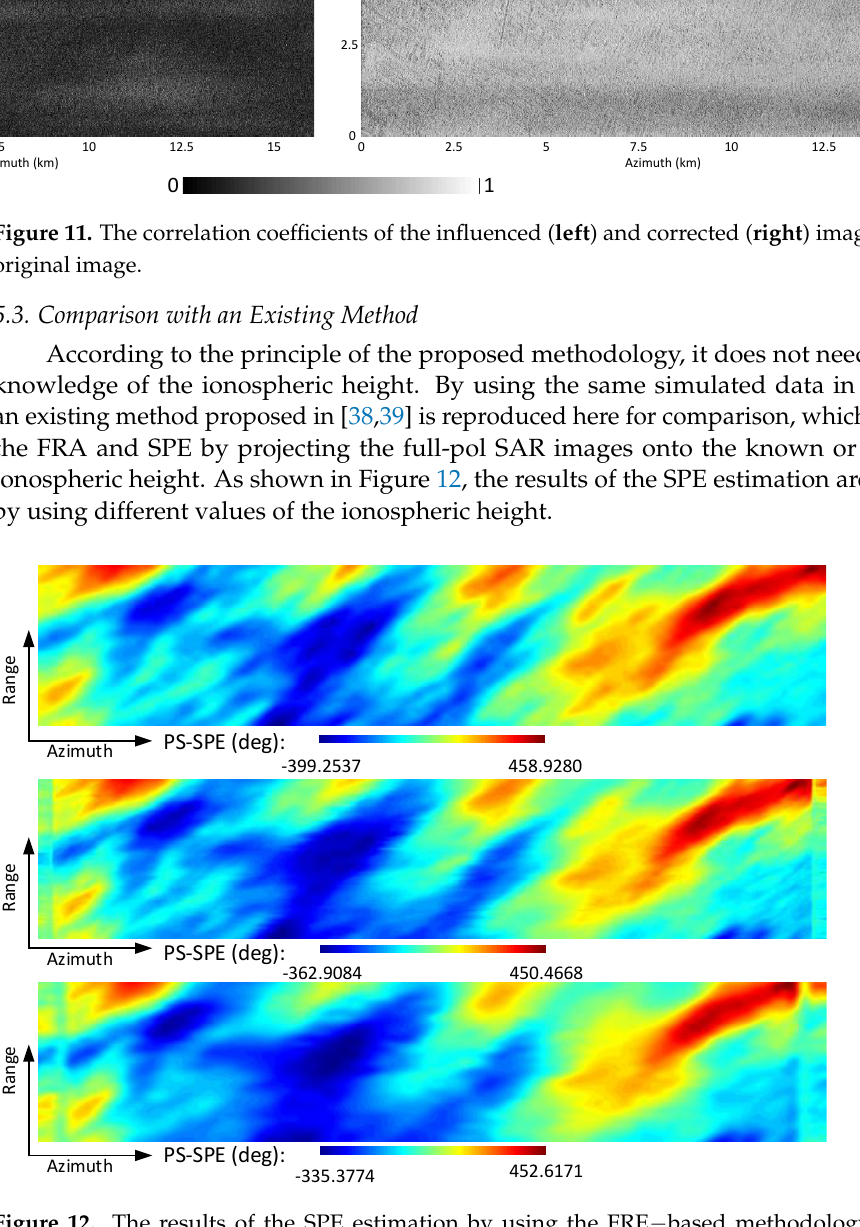
Figure 12. The results of the SPE estimation by using the FRE − based methodology proposed in [38,39], which depends on the parameter of the ionospheric height. The values of the ionospheric height of 350 km ( top ), 300 km ( center ), and 250 km ( bottom ) are